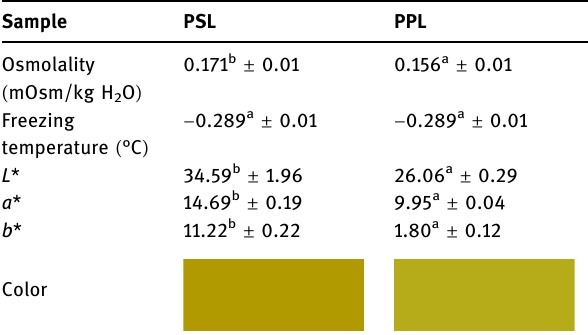
Table 1: Characteristics of the tested P. padus and P. serotina leaves, given in CIE L * a * b * units and osmolality Sample